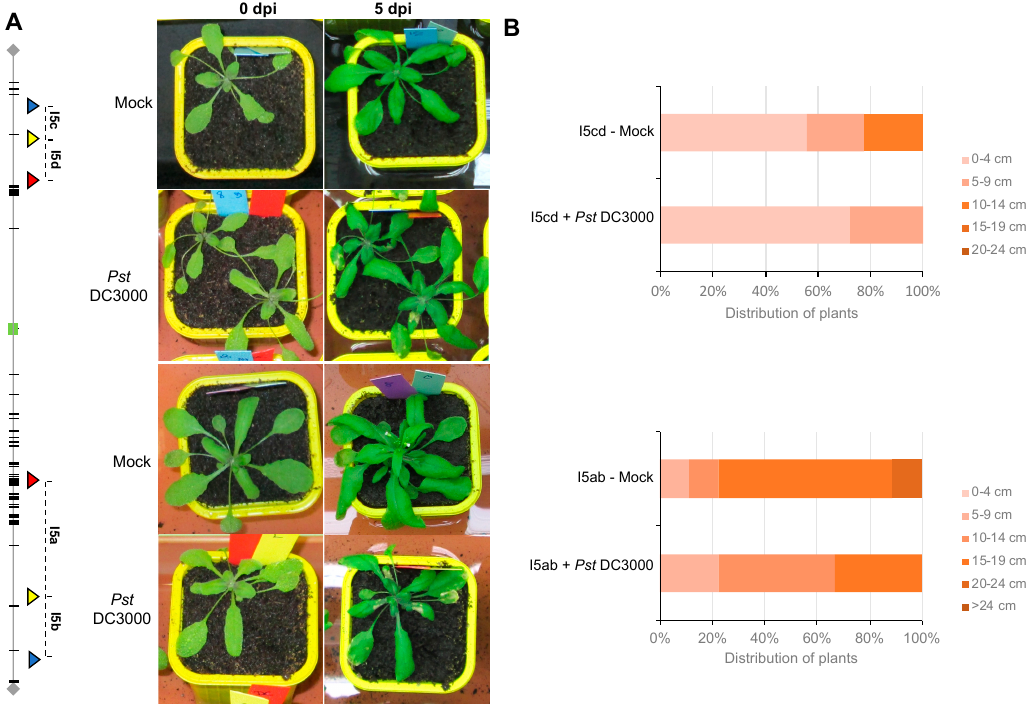
Figure 3. Phenotype of FTL lines after infection with P. syringae . ( A ) Symptoms observed on Arabidopsis FTL lines after P. syringae infection at 5 dpi (after the first inoculation). The plants of FTL lines, I5cd (Upper panel) and I5ab (Lower panel), were sprayed with P. syringae DC3000 or with MgCl 2 only as a control. Typical brown symptoms, including water-soaked lesions on the leaves, were visible at 5 dpi (after the first inoculation) on infected plants only and were still present when flowers were collected. ( B ) Floral stem development at 12 dpi (after the first inoculation) in mock- and in Pst -inoculated plants. The length of the floral stem was measured at 12 dpi on mock- or Pst DC3000- inoculated plants, for each FTL line, I5cd (Upper panel) and I5ab (Lower